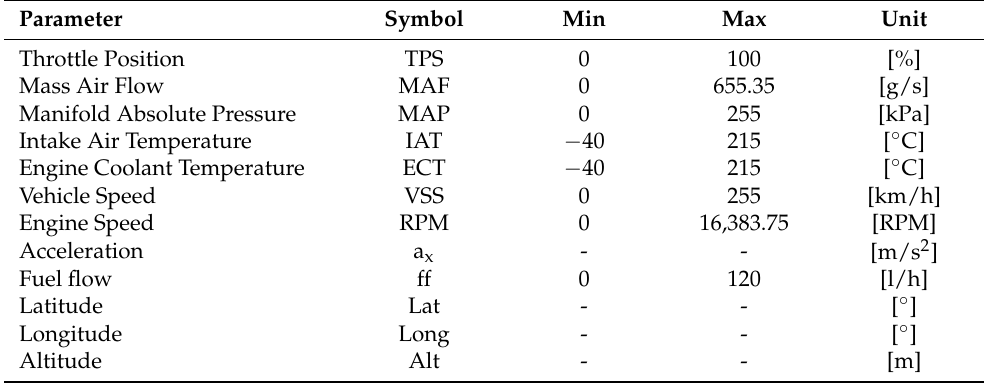
Table 1. Operating and driving parameters.